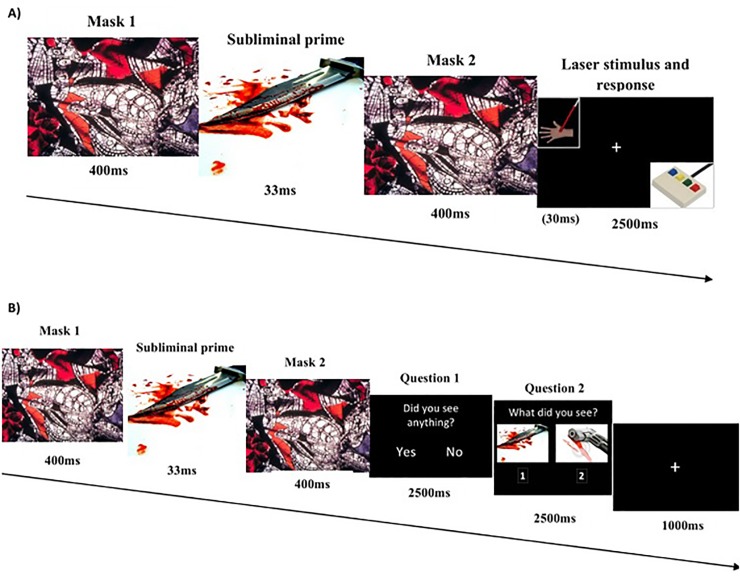
Schematic representation of the experimental sequences described in the main text for A) the visual masking task, and B) the picture detection test. A) An example of an A- trial is presented. B) An example of a picture detection test of the same trial (A-)―the sequence of each trial was identical to the one used in the experimental task except for the two questions displayed at the end of each trial: 1) the first, ‘Did you see anything?’ 2) the second, ‘What did you see?’ This question was displayed along with two different pictures: one was the emotional masking picture (belonging to the emotional picture set used in the experimental session); the other was a comparable picture in both emotional category and visual characteristics (shape and colours) to the experimental stimulation (for additional details see [26]).